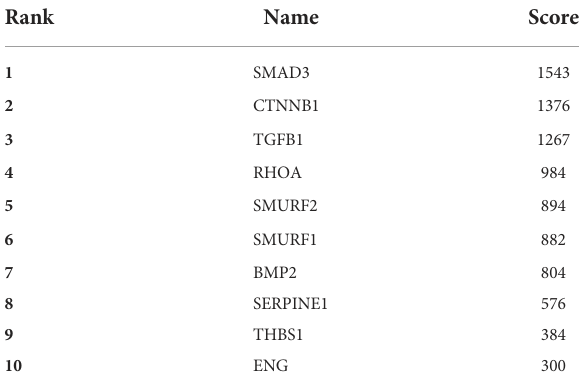
TABLE 3 Top 10 STRING interactions of genes screened by the MCC